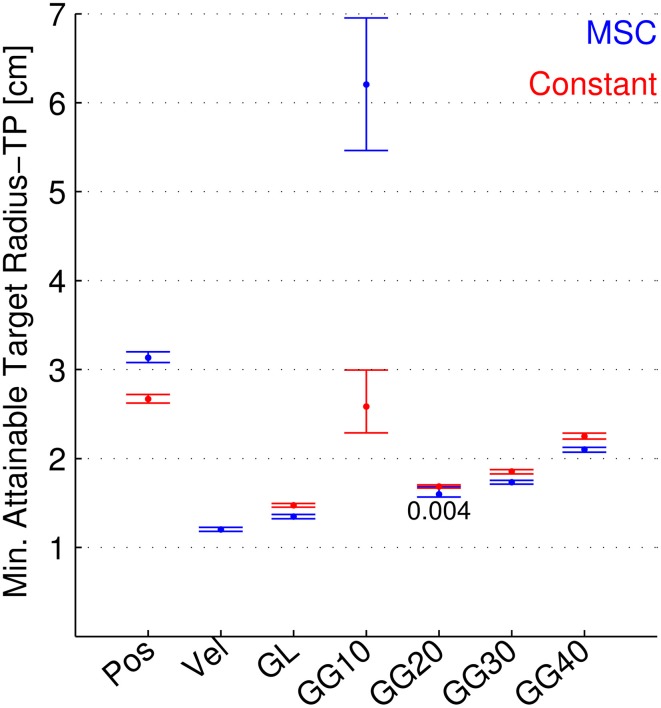
Minimum attainable target radius for separate neuron types, both continuously modulated and constant. The minimum attainable target radius (MATR-TP, see text) is shown for position, velocity, linear goal (GL), Gaussian 10 cm tuning width goal (GG10), 20 cm (GG20), 30 cm (GG30), and 40 cm (GG40). Blue error bars indicate mean and 95% confidence intervals for the MATR-TP using 50 of the respective neurons and the Multiple Submovement Controller. Red error bars indicate the same metric for constant (i.e., not corrected) trajectory commands, for position and goal tuning.